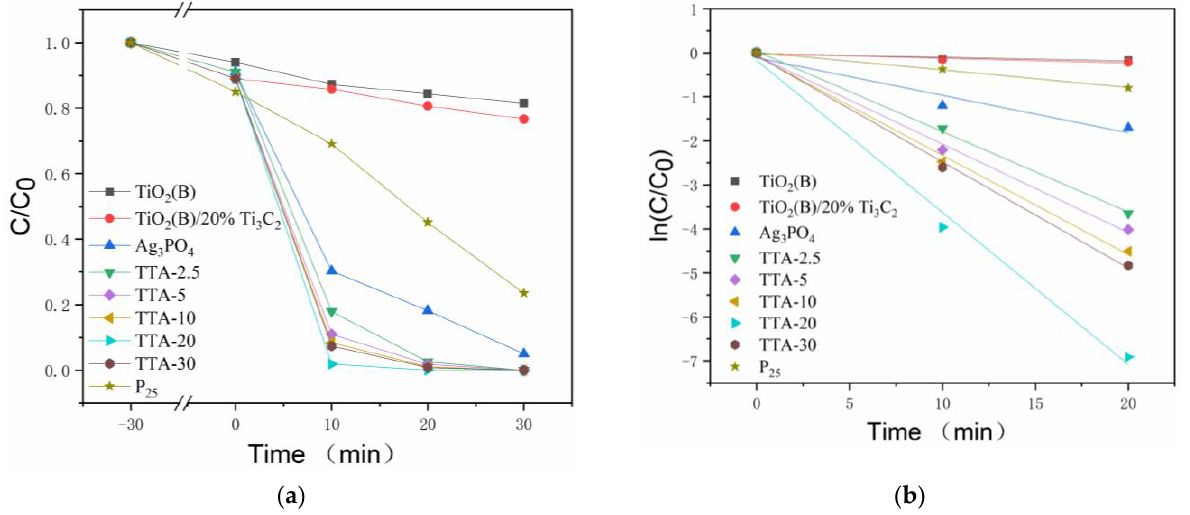
Figure 3. ( a ) Photocatalytic degradation curves; ( b ) linear fittings of degrading kinetics under different catalytic conditions.